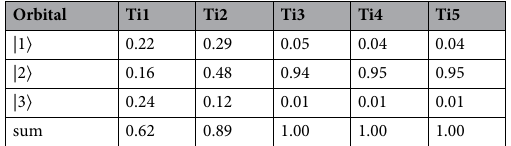
Table 1. Temperature-averaged effective Ti( t